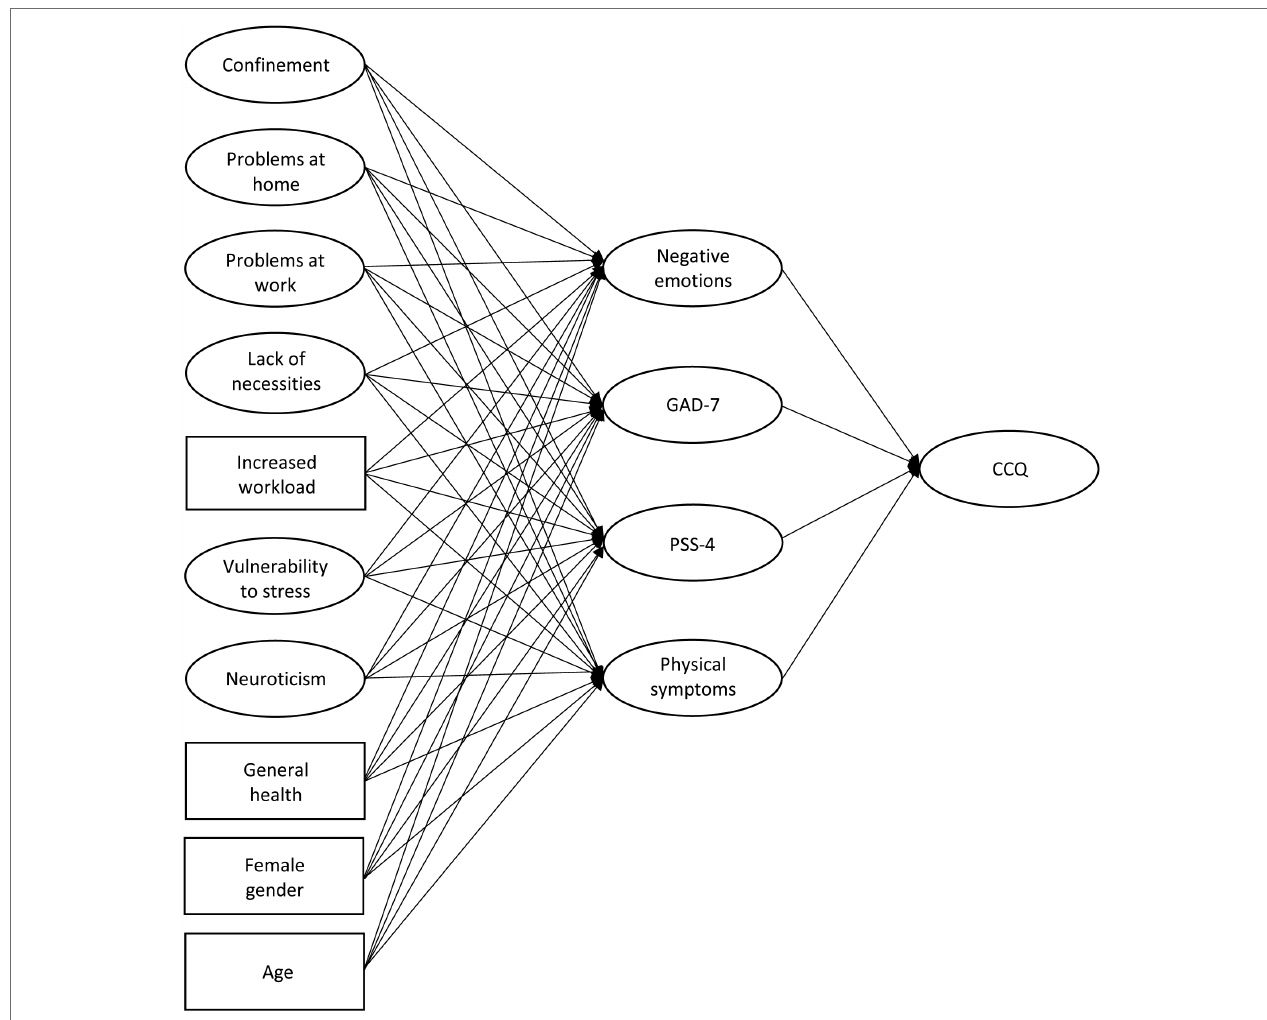
FIGURE 1 | A simplified representation of the structural model for predicting subjective cognitive change. Negative emotions, generalized anxiety (GAD-7), perceived stress (loss of perceived control; PSS-4), and physical symptoms mediate the effects of stressors and stress risk factors on subjective cognitive change